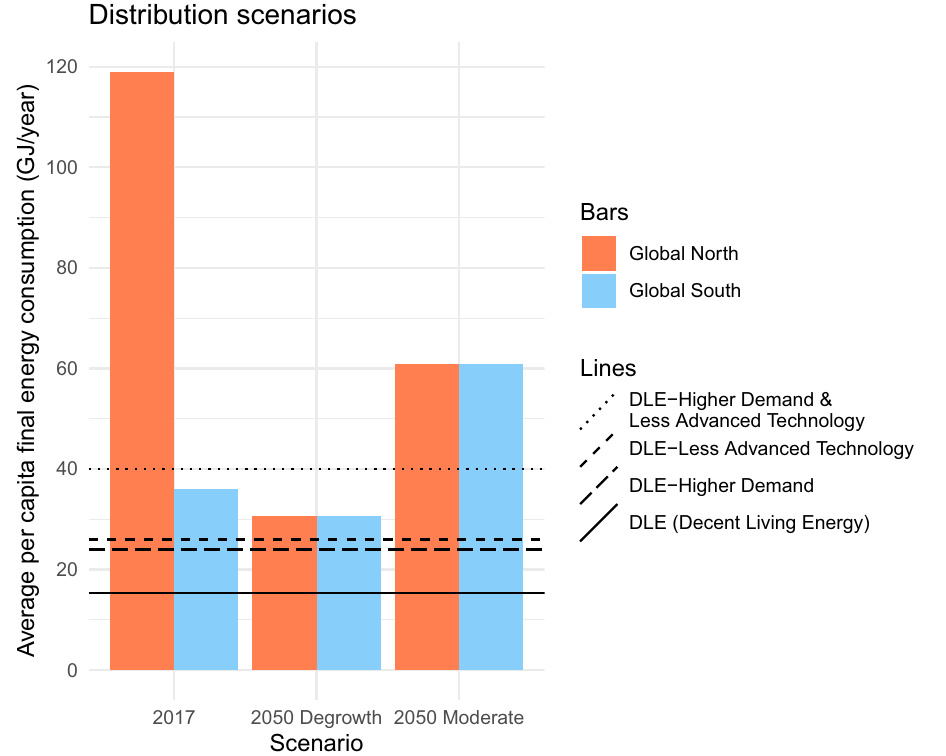
Fig. 6 A fi nal energy distribution scenario for our 1.5 °C ‘ degrowth ’ and ‘ moderate ’ scenario, assuming an equal per capita distribution among 10 billion people in 2050. We additionally include historical data for 2017 and all Decent Living Energy (DLE) scenarios modelled by Millward-Hopkins et al. 20 , which give an approximation of the energy use for basic human needs satisfaction under varying assumptions. The global North here comprises the OECD, non-OECD Europe and Eurasia, whereas the South comprises all other regions from the IEA 63 . Note that we use territorial and not consumption- based data, which is likely to understate the differences in 2017 48